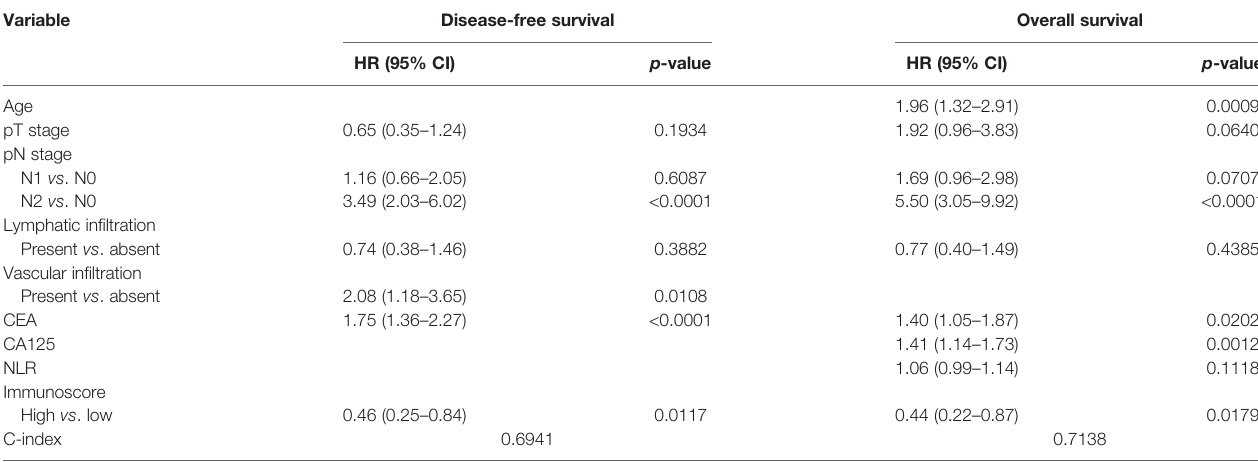
TABLE 2 | Multivariate Cox proportional hazards regression analysis for disease-free survival (DFS) and overall survival (OS). Variable